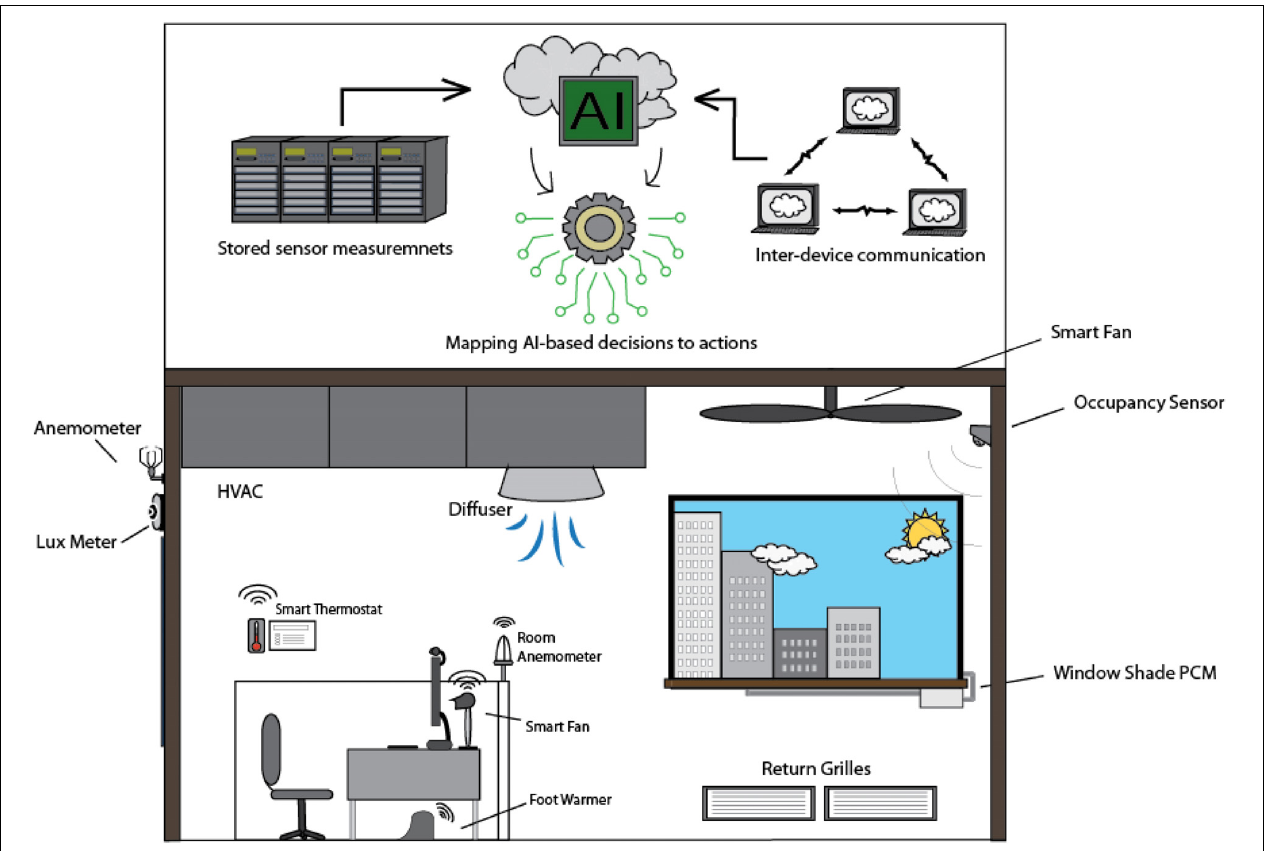
FIGURE 7 | Sensors are connected to the building automation system and relay real-time sensor measurements that allow for optimal performance of the AI-based